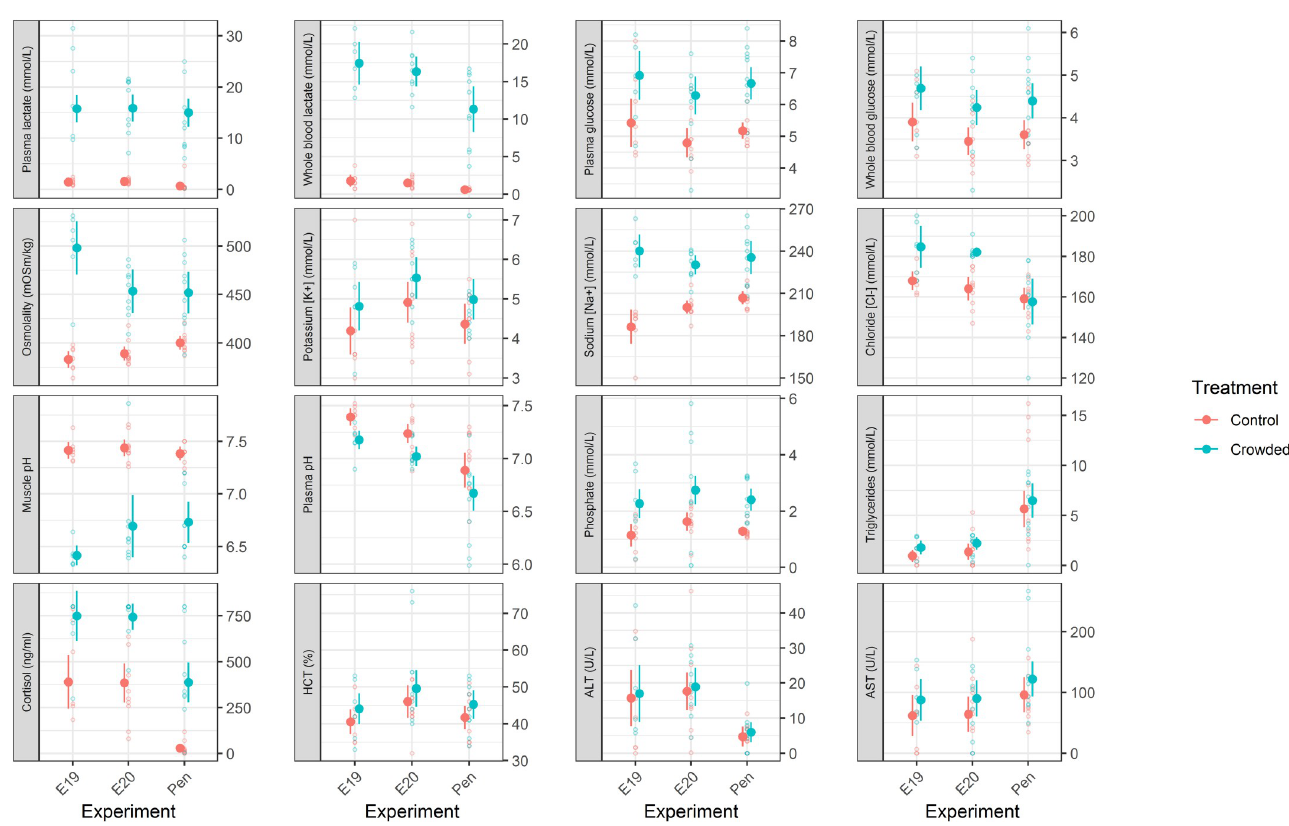
Fig 1. Blood and muscle physiology responses to crowding in Atlantic mackerel. Model predicted mean control and crowded values are shown as filled circles, with associated 95% confidence intervals as whiskers. The underlying dataset is shown as open circles. Data points are coloured according to treatment. HCT refers to haematocrit, ALT to alanine transaminase and ASP to aspartate transaminase.